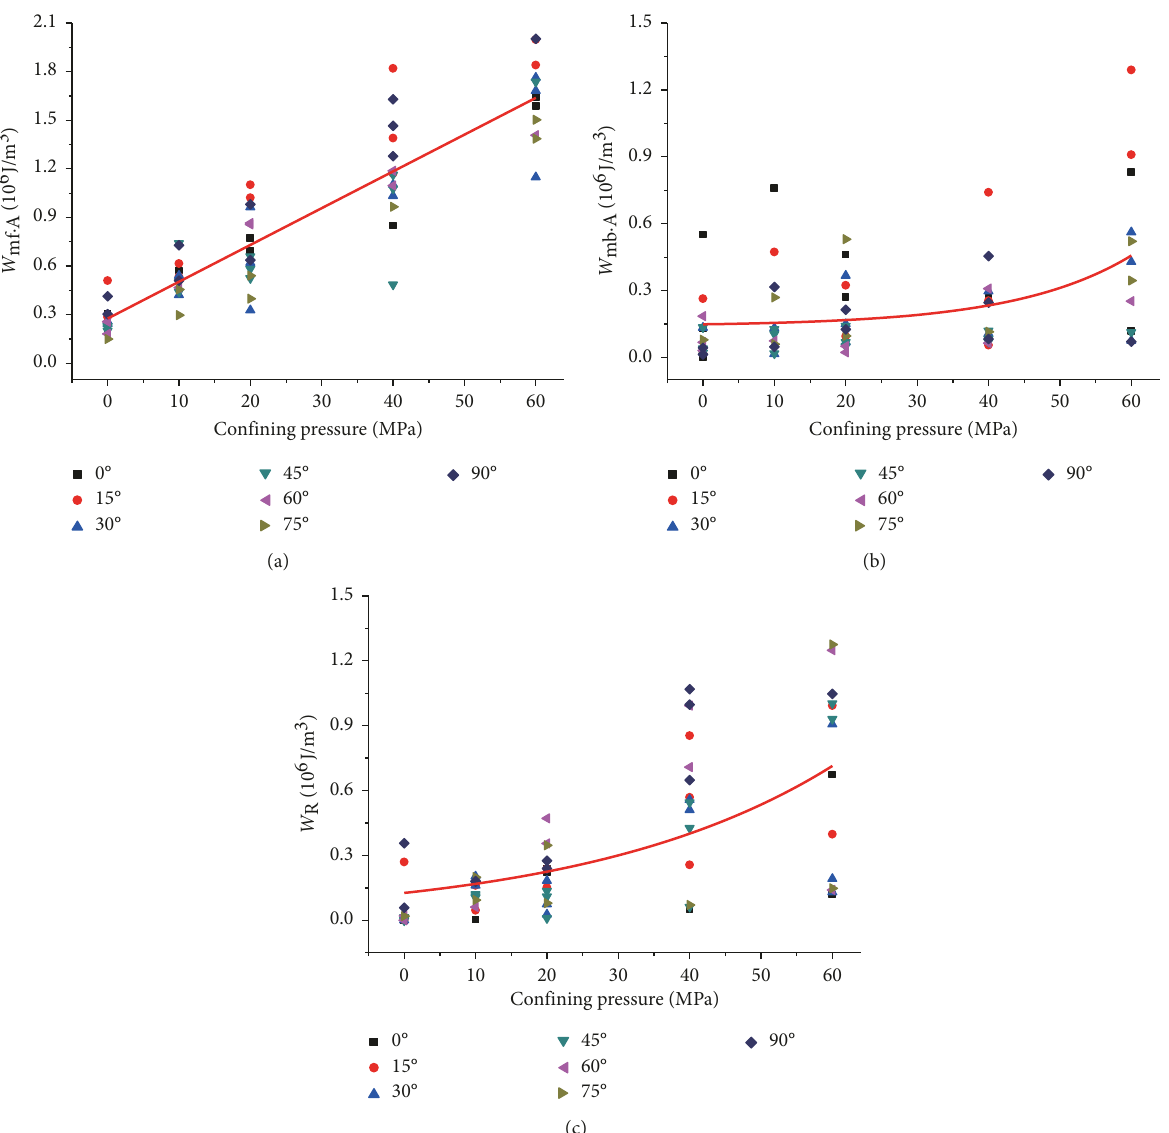
Figure 14: Relationship between energy, or work, related to brittleness and confining pressure. (a) The energy accumulated at the axial prepeak stage. (b) The work done by press at the axial postpeak stage. (c) The residual strain energy at the postpeak